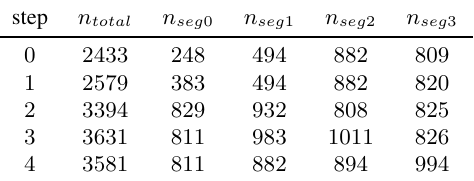
Table 3. Amount of points n captured at each step when flying the autonomous segment inspection with a r flight of 3 m ( 2 m distance to the object surface) with ω = 0 . 25